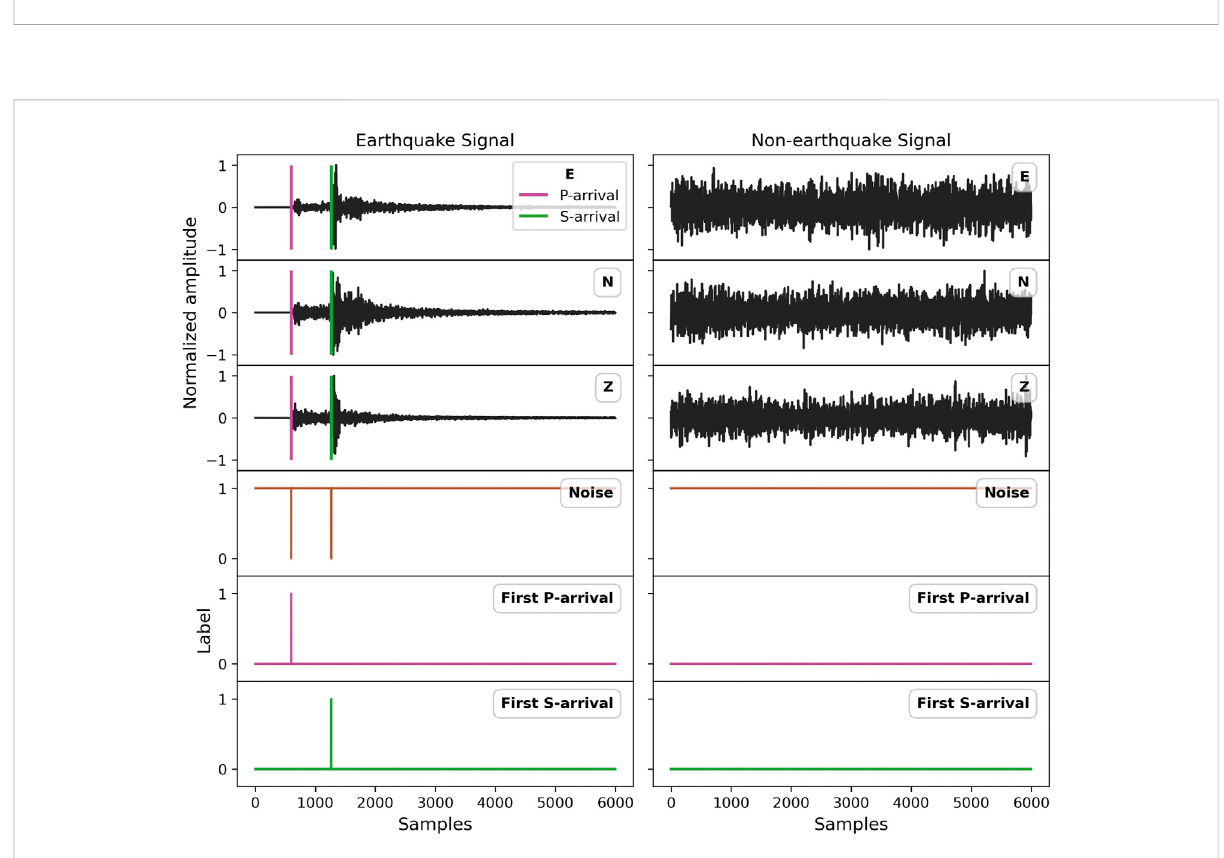
FIGURE 3 Visualization of training examples including one earthquake event and non-earthquake signal of the STEAD dataset (Mousavi et al., 2019). The three plots at the top of each sub fi gure in black color represent the normalized three-component seismograms, where the colored vertical lines denotethepickedarrivaltimeofP-andS-phasefromtherecordedearthquakecatalogoftheSTEADdataset(Mousavietal.,2019).Thebottomthree plots denote the label information, where the label of each sample is encoded as a one-hot